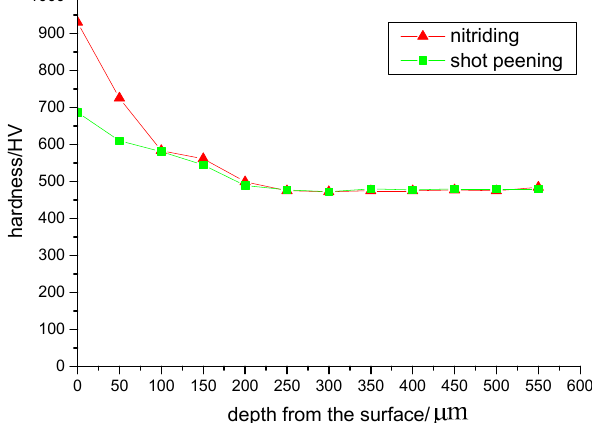
Figure 4. Micro-hardness distribution under different surface treatments.